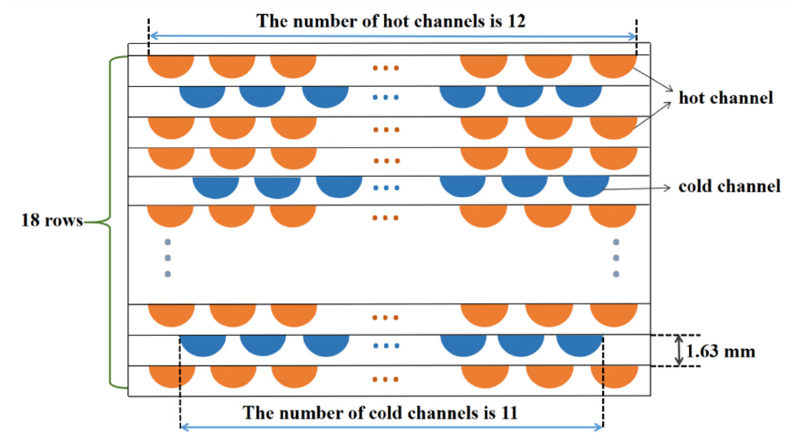
Figure 2. Diagram of PCHE channel